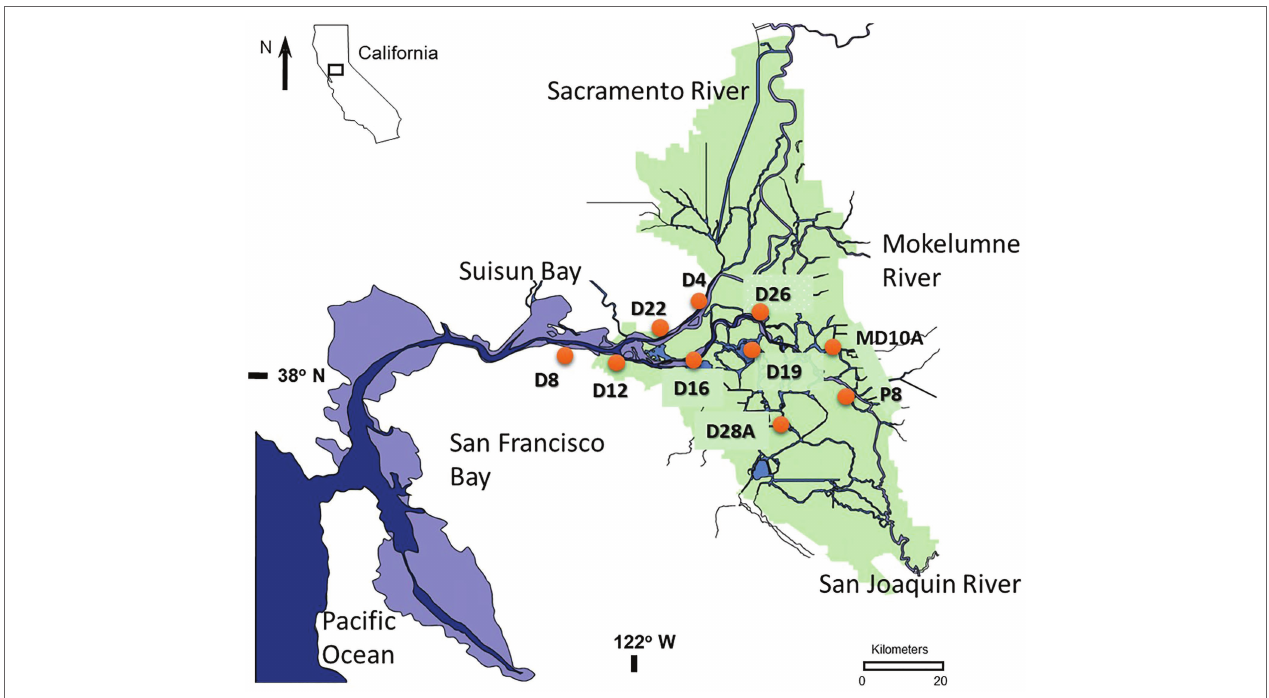
FIGURE 1 | Map showing the location of 10 stations sampled between 2014 and 2018 in the upper San Francisco Estuary